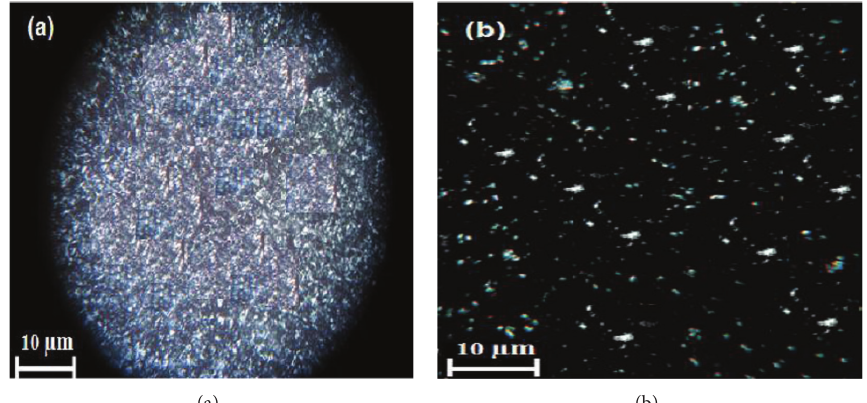
Figure 5: Polarized microscopic image morphologies of (a) untreated and (b) treated Norpetco crude oils with 5000 ppm of VASM (1: 2) at their pour point temperatures.